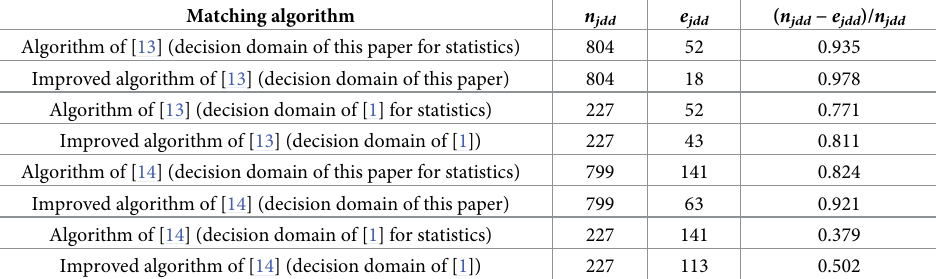
Table 2. Test result of DS